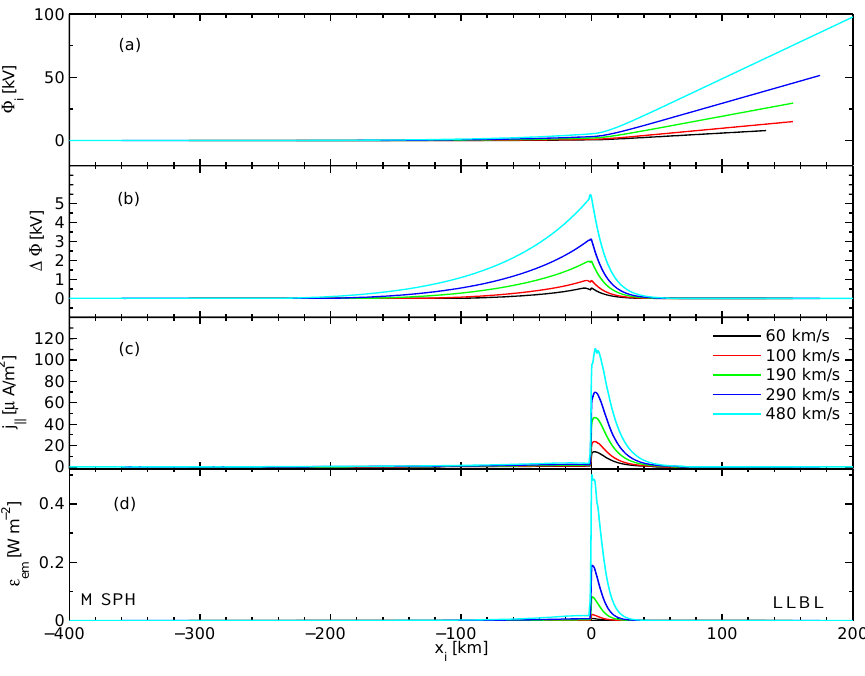
Fig. 4. Solution of Eq. (1) and derived quantities obtained as a function of ionospheric latitude x i for various bulk velocities on the LLBL side of the TD: (a) the ionospheric potential ; (b) the field-aligned potential drop; (c) the field-aligned current density; (d) the flux of precipitating energy. The temperature and density of the magnetospheric and ionospheric populations are given in Tables 1 and 2.